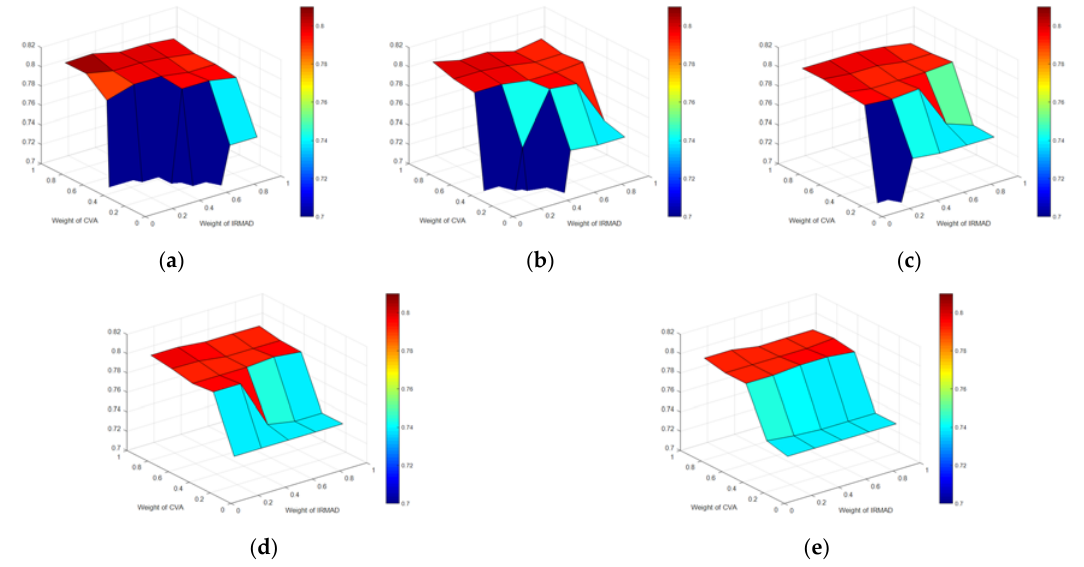
Figure 14. The quantitative evaluation with the ISFA weight of ( a ) 0.1; ( b ) 0.3; ( c ) 0.5; ( d ) 0.7; and ( e ) 0.9 in test dataset 2.